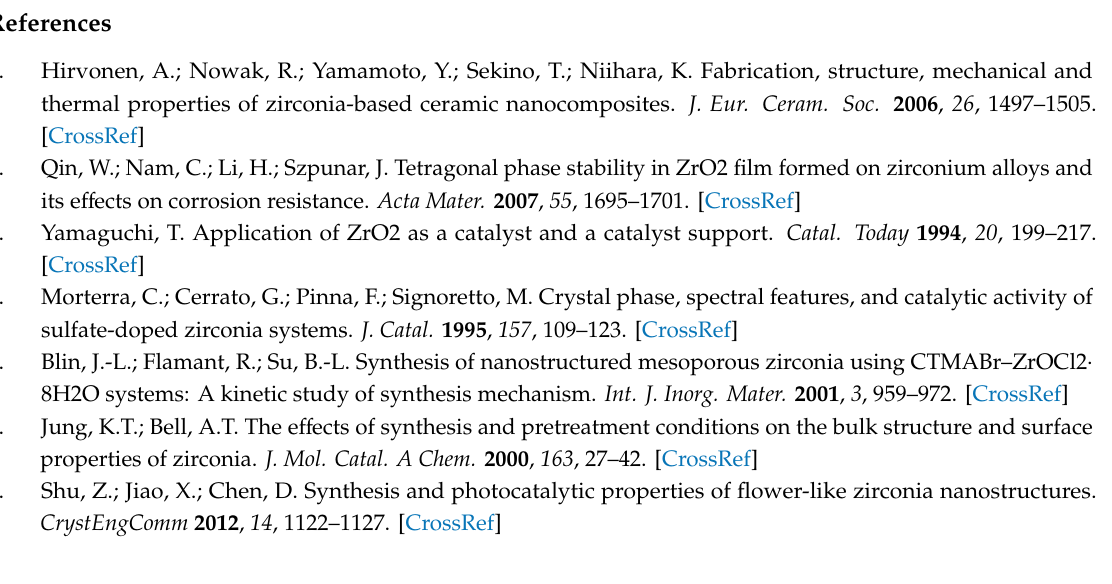
Figure S1: FESEM image of as-synthesized zirconias without the DTAB assistance, Figure S2: TEM images of as-synthesized zirconias without the DTAB